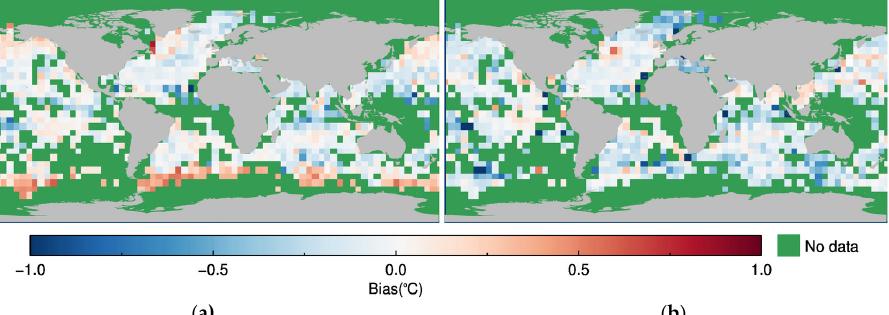
Figure 3. Global distribution of mean biases in 5° × 5° boxes for ( a ) the NAVO N-SPP VIIRS SST and ( b ) the AQUA MODIS SST with respect to the drifter measured SST during 2014.